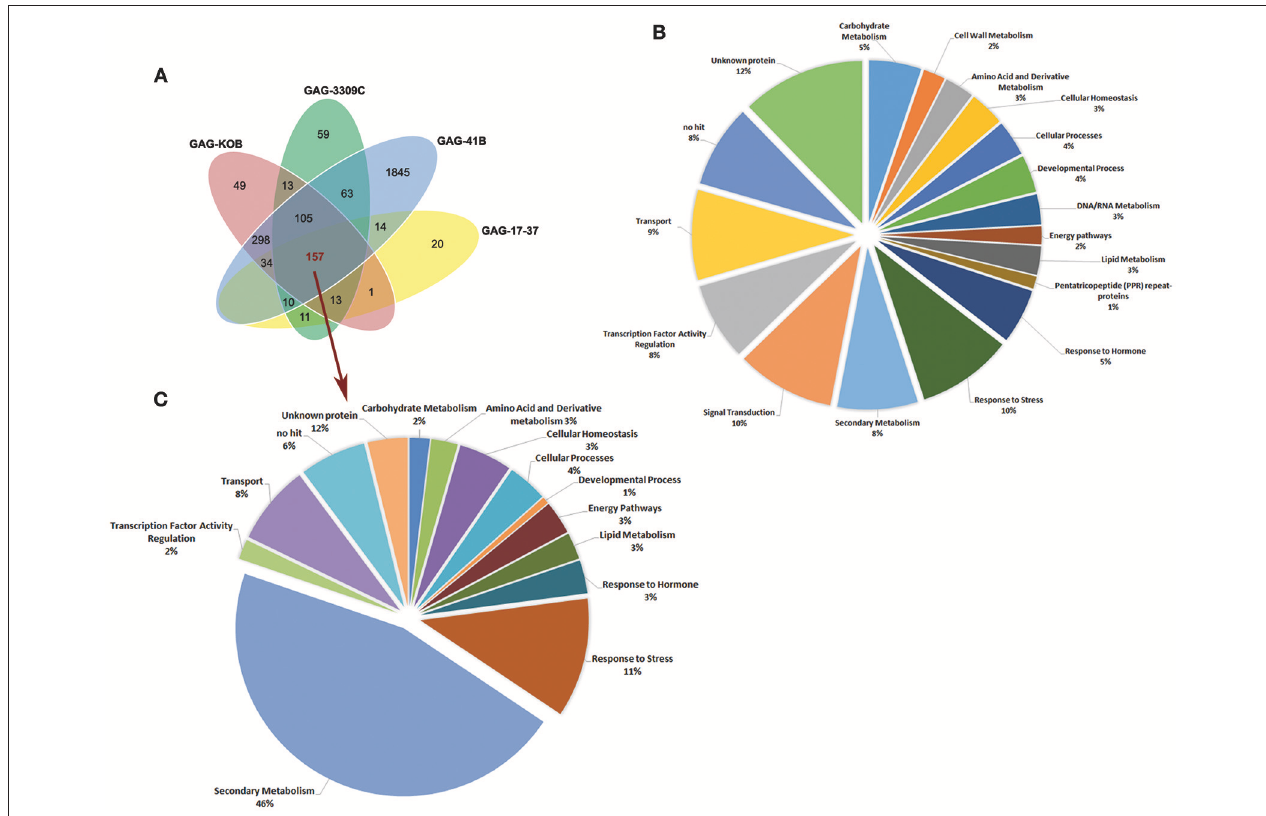
FIGURE 1 | Venn diagrams showing the distribution of the 2,692 DEGs ( P < 0.05; |log2FC| ≥ 2) in the graft combinations GAG-KOB, GAG-3309C, GAG-41B, and GAG-17-37, each compared to the reference GAG-1103P (A). Functional category distribution of the 2,692 DEGs (B) and of the 157 genes showing common differential expression in all the graft combinations (C) . Transcripts were grouped into the most represented functional categories, based on the GO classification of biological processes.